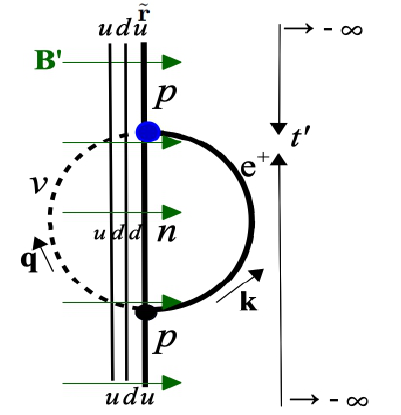
Figure 2 . Diagrammatic representation of h W i B 0 for a quasi-stationary magnetic (cid:12)eld B 0 , accord- ing to eq. (F.3). The calculation is performed in the adiabatic limit, where the initial time is taken to (cid:0)1 according to eq. (C.4), and the operator W , represented with a blue circle, applies at the observation time t 0